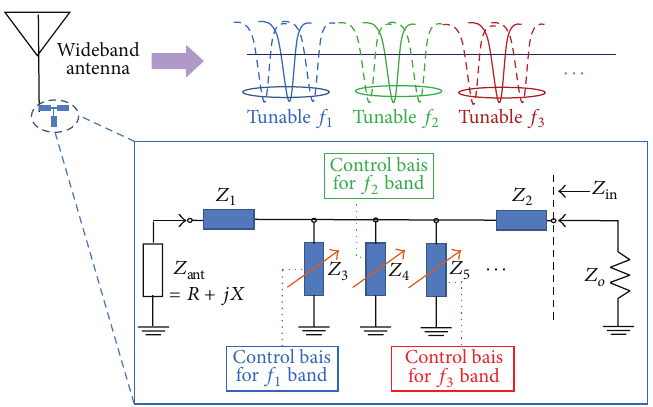
Figure 1: Tunable multiband system using novel tunable cross-type